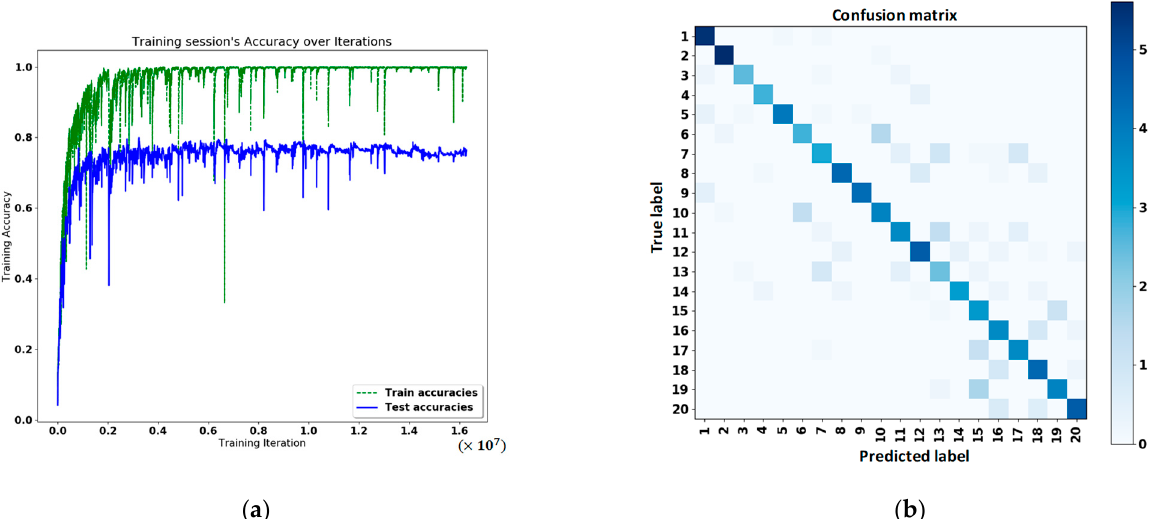
Figure 10. Twenty categories of 10 people. ( a ) Training accuracy results; ( b ) classification results.